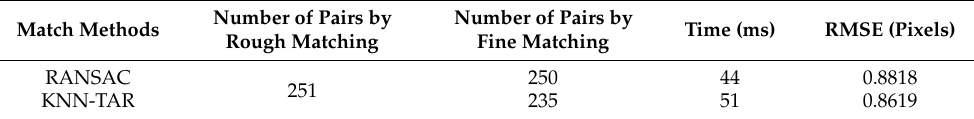
Table 1. Comparison of the KNN-TAR and RANSAC algorithms for GF-1 images. Match